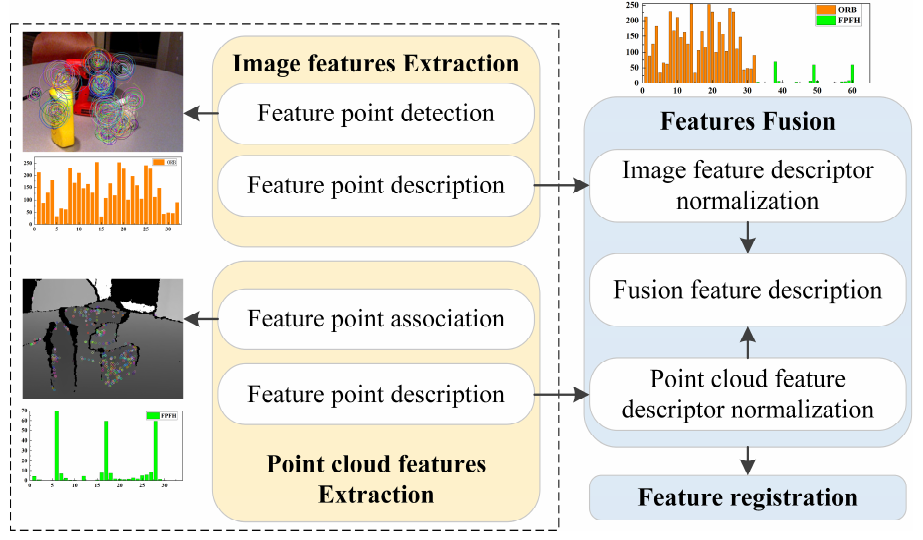
Figure 1. Sample graph with blue (dotted), green (solid), and red (dashed) lines.